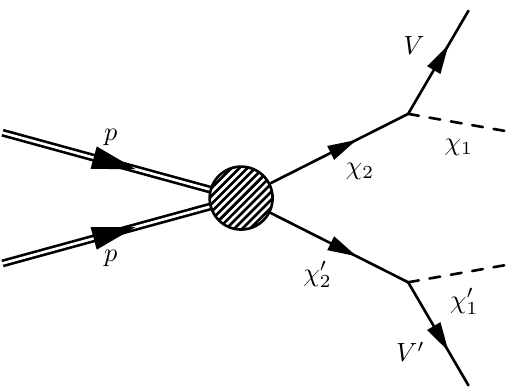
Figure 1 . Topology of the displaced decays considered in this work. Two long-lived parent particles (cid:31) 2 are produced from the primary collision and then decay with a displaced vertex to an invisible daughter (cid:31) and something visible V , which can be either a single particle or the sum of more 1 particles in the (cid:12)nal